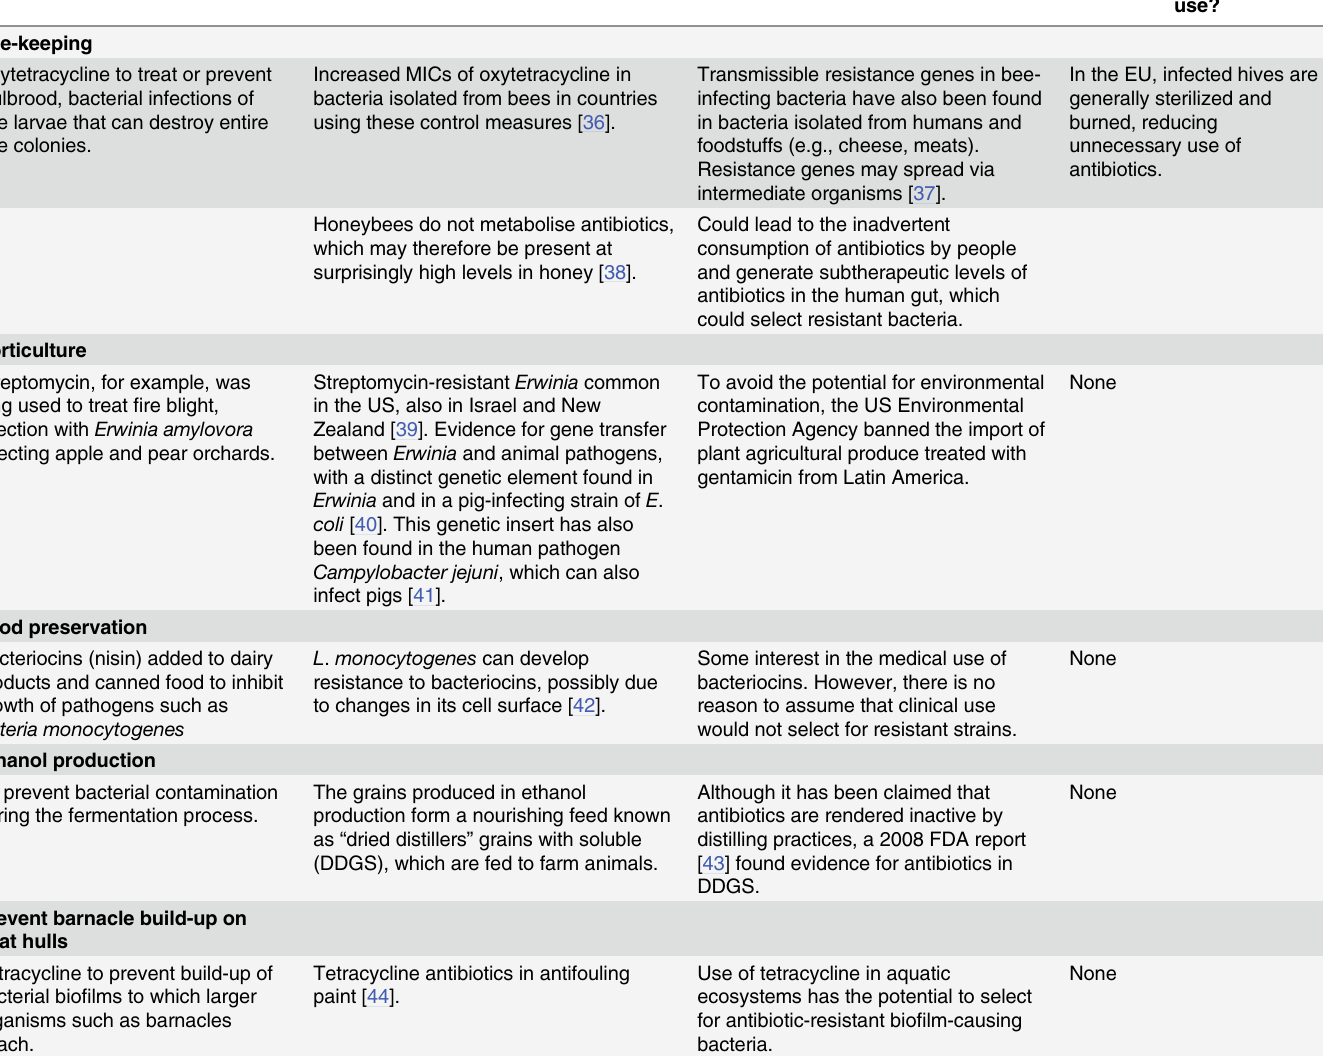
Table 1. Other nonmedical uses of antibiotics with evidence of or potential transfer of resistant bacteria or genes to humans and impact.